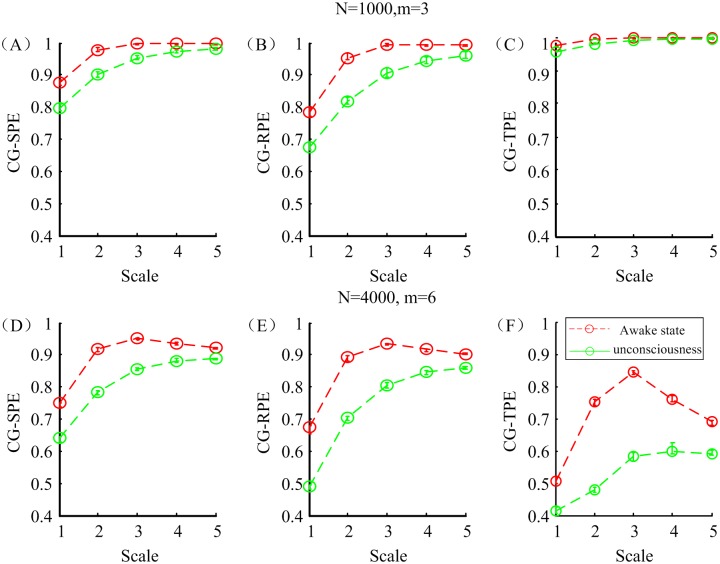
The CG-SPE, CG-RPE and CG-TPE indexes with different parameters in awake and anesthesia states.(A-C) The mean and standard deviation of three indexes with parameters: N = 1000, m = 6, τ = 1, a = 2 and q = 0.1 (D-F) The mean and standard deviation of three indexes with parameters: N = 4000, m = 6, τ = 1, a = 2 and q = 0.1.